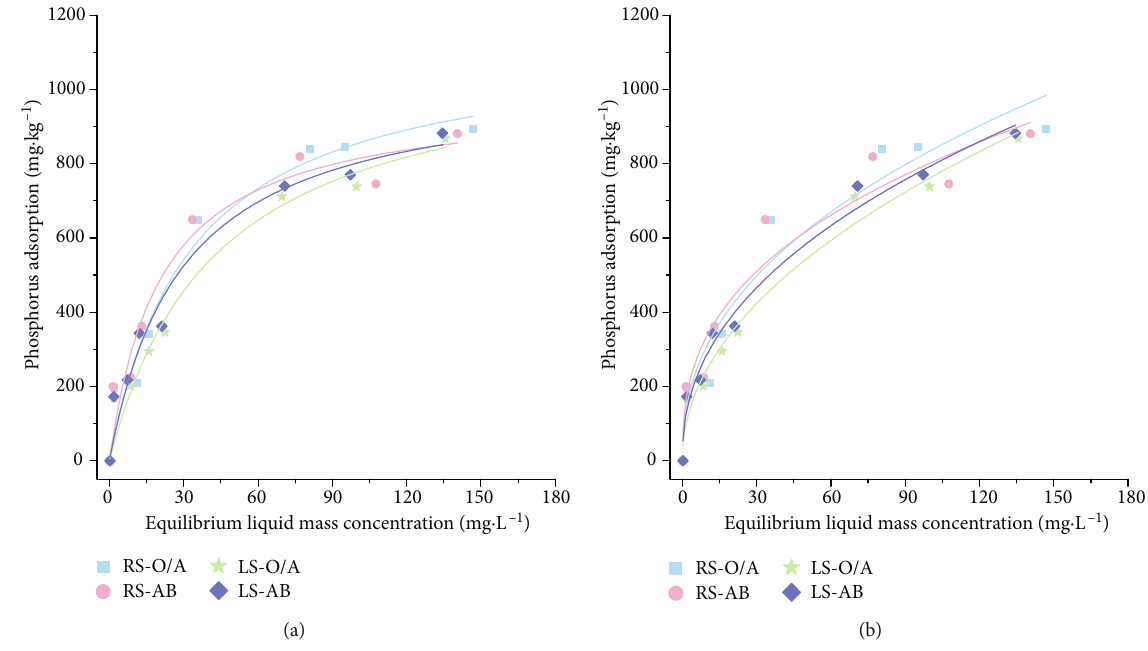
Figure 1: Fitting curve of (a) Langmuir and (b) Freundlich model for the O/A and AB horizons of the red soil (RS) and limestone soil (LS). Table 2: Parameter of adsorption isotherm fi tting curve and PSI of the O/A and AB horizons of the red soil (RS) and limestone soil (LS). Langmuir equation Freundlich equation Soil types Q RS-O/A LS-O/A